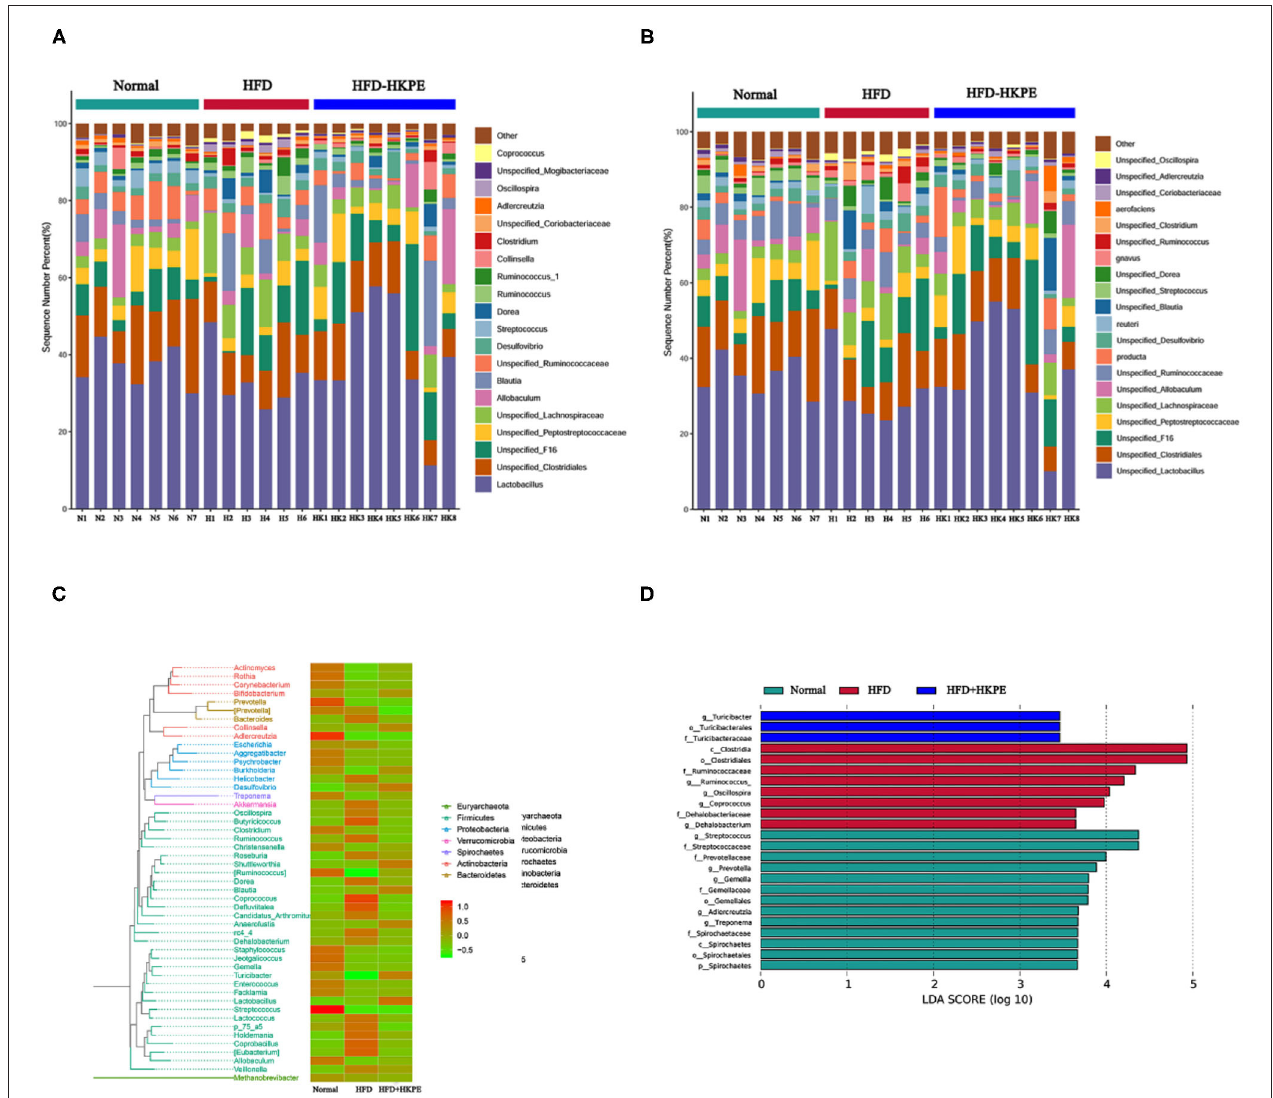
FIGURE 3 | KPE supplementation alters gut microbiota. (A) Relative abundance of genus level; (B) Relative abundance of species level; (C) Phylogenetic_tree_heat map; (D) Genus lefse LDA, the heat map showing normalized relative abundance using the equation log 10.